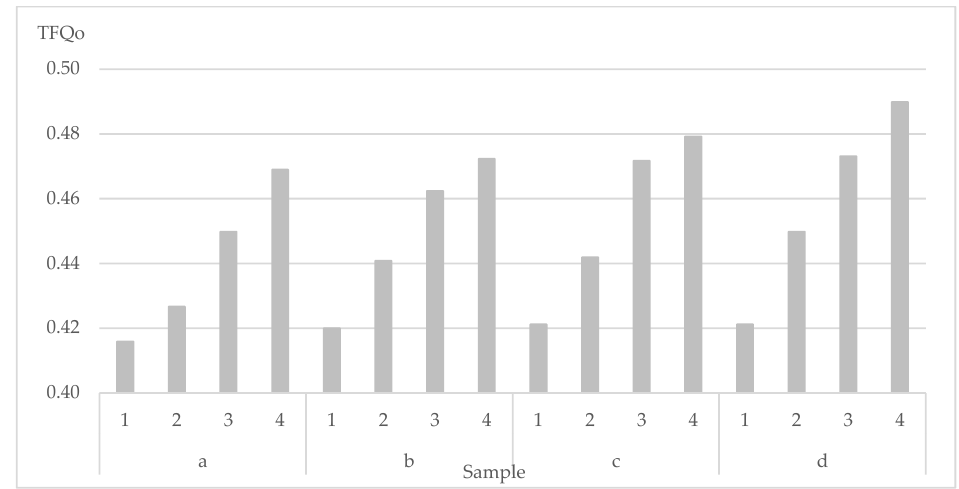
Figure 2. Heat transmission factor influenced by weft yarn fineness and raw material.